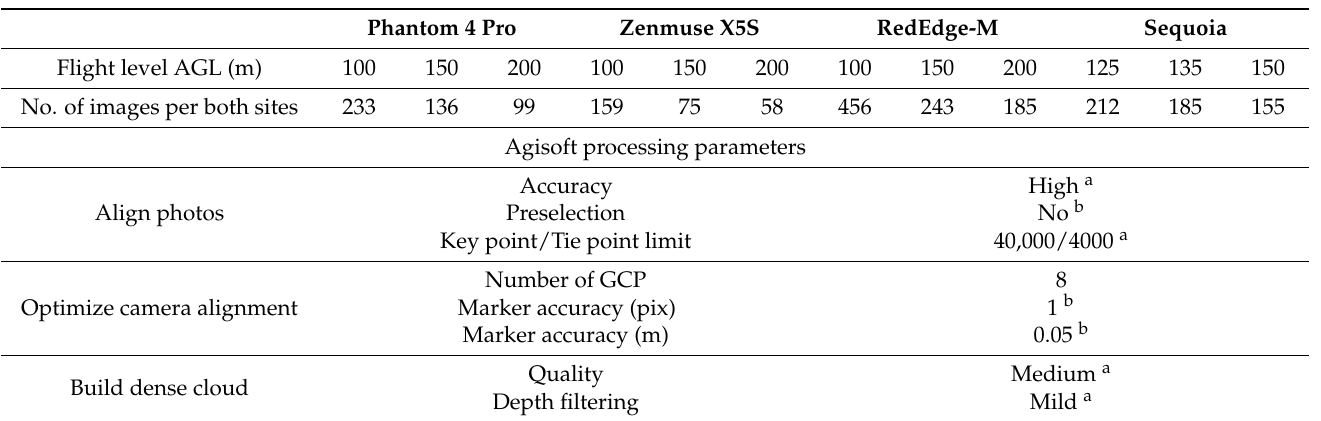
Table 2. Number of acquired images of each camera, and the flight level and Agisoft processing